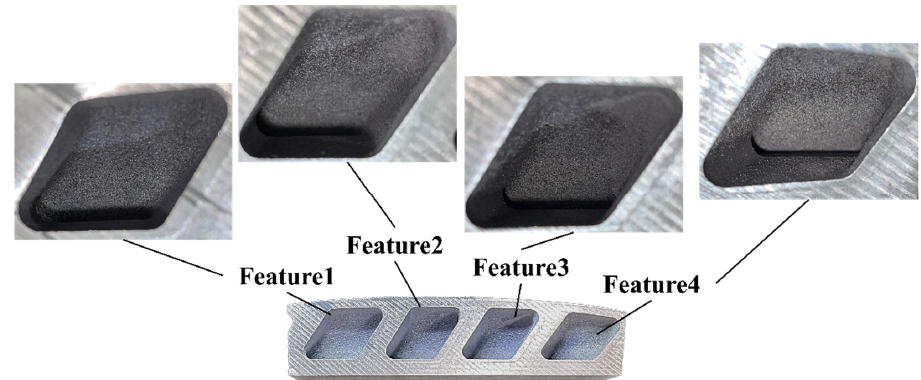
Figure 20. Fabricated sample 1 and its features for comparison.